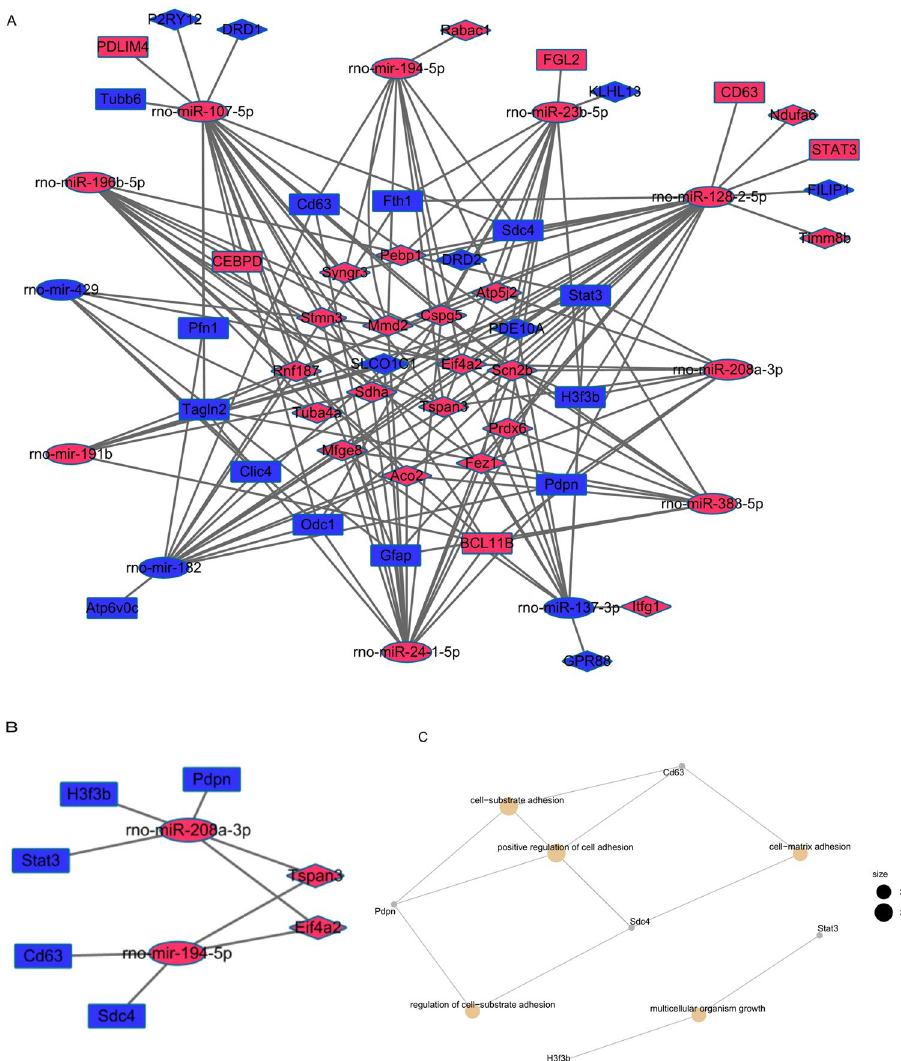
Figure 10. DELs mediated ceRNA regulatory network in Cerebral Infarction. ( A ) DELs mediated ceRNA network; ( B ) The sub-network; ( C ) The cnetplot of mRNAs in the ceRNA regulatory network. The red nodes indicate up-regulation expression while blue down-regulation. DELs, DEMis and DEMs are indicated by diamonds, ellipses, and rectangle,